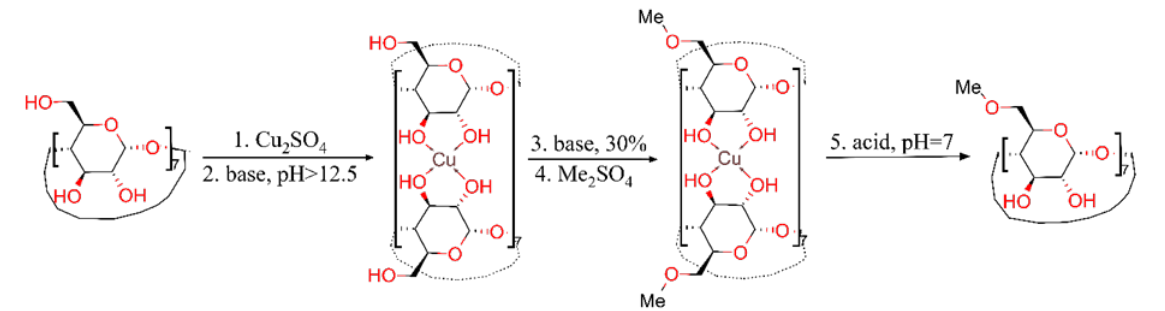
Figure 3. Synthesis of heptakis(6- O -methyl)- β -cyclodextrin ( MβCD) .